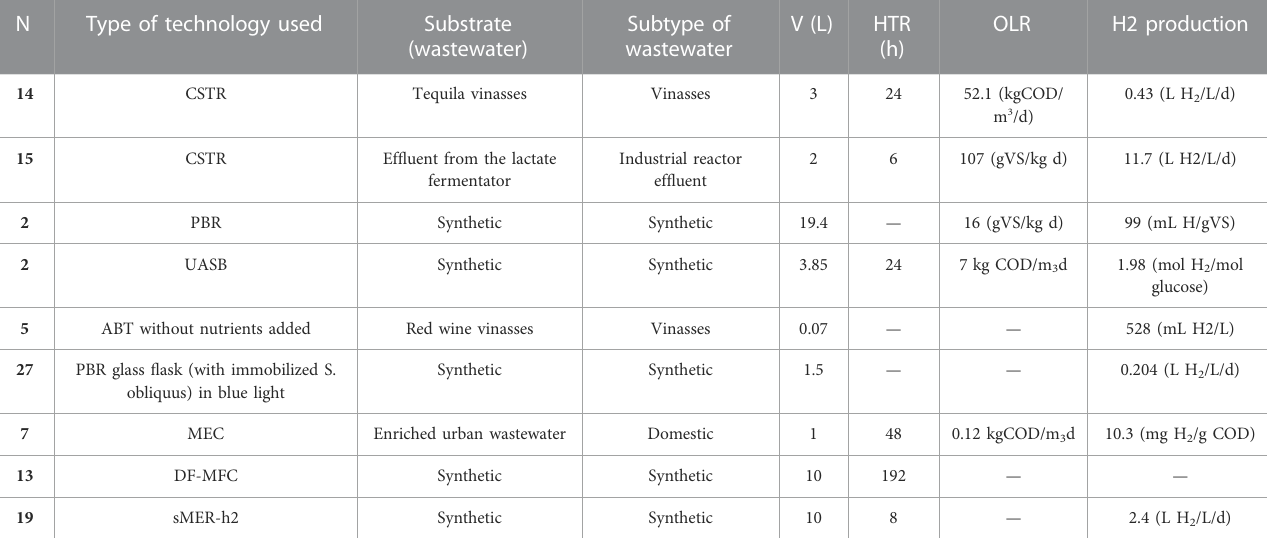
TABLE 6 Hydrogen production wastewater and basic